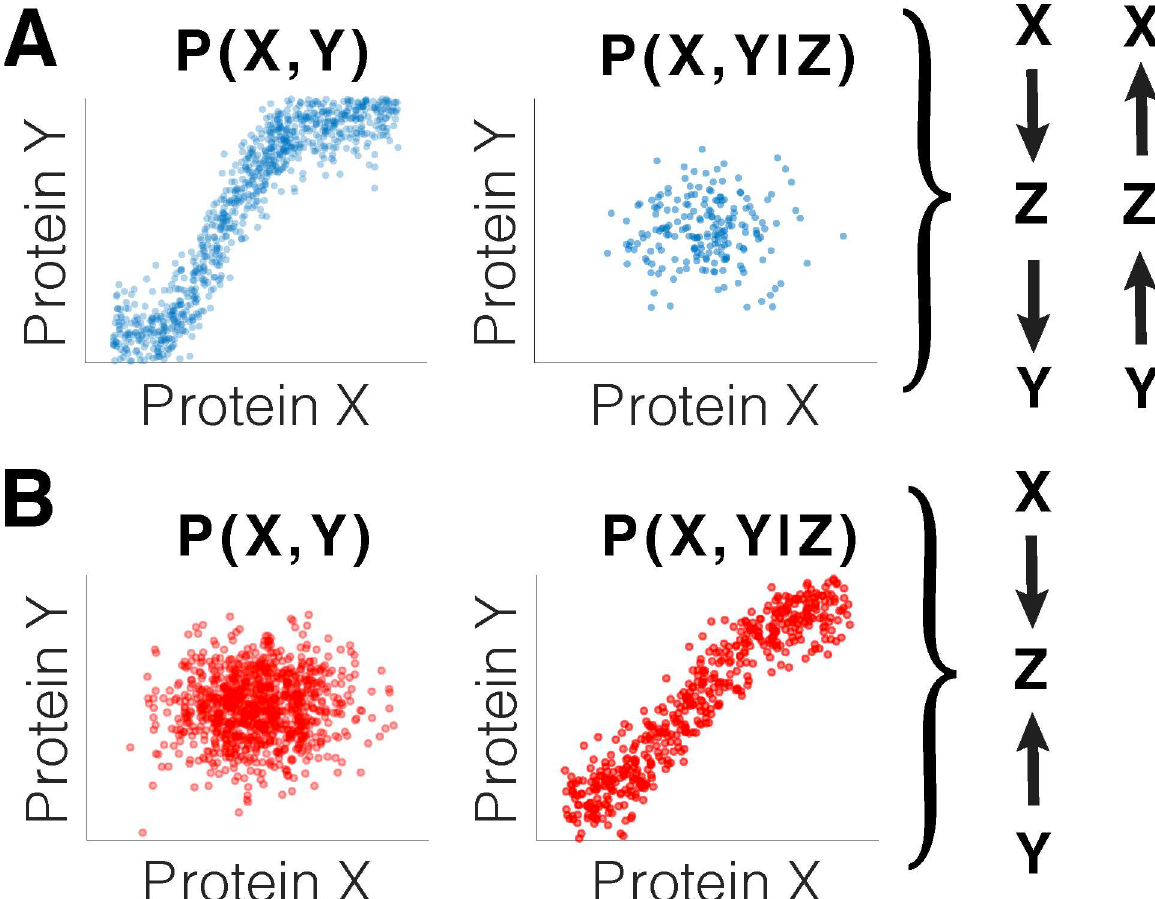
Fig 1. Inference of direct regulatory interactions with minimal assumptions. (A) The observed joint distributions of proteins X and Y across many single cells are consistent with 2 models in which protein Z is a confounder. (B) The joint distributions of proteins X and Y across many single cells are consistent with a “collider” model, in which X and Y collide at Z, inducing dependence conditional on Z. The arrows indicate directions of causality (positive or negative regulation), and in the collider model one of the arrows corresponds to positive and the other to a negative regulatory effect. Such inference of direct regulatory interactions requires no specific assumptions, but it does require accurate measurements across many single cells.